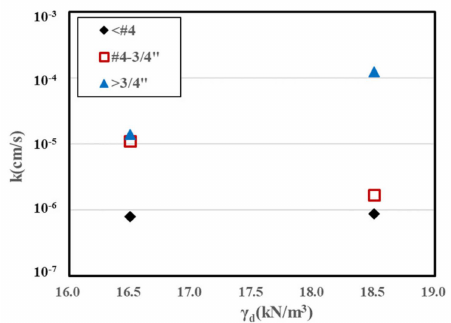
Figure 17. Permeability coefficient vs. dry density for different clods